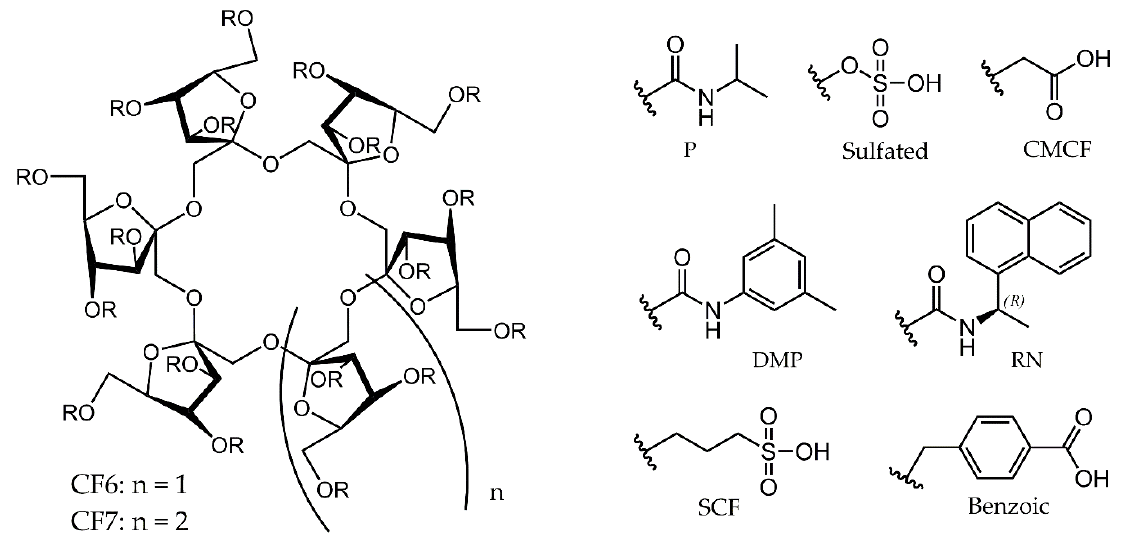
Figure 1. The structures of ( R,R )-bis-(1,1′-binaphthyl)-22-crown-6 (left) and ( + )-(18-crown-6)-2,3,11,12-tetracarboxylic acid (right).